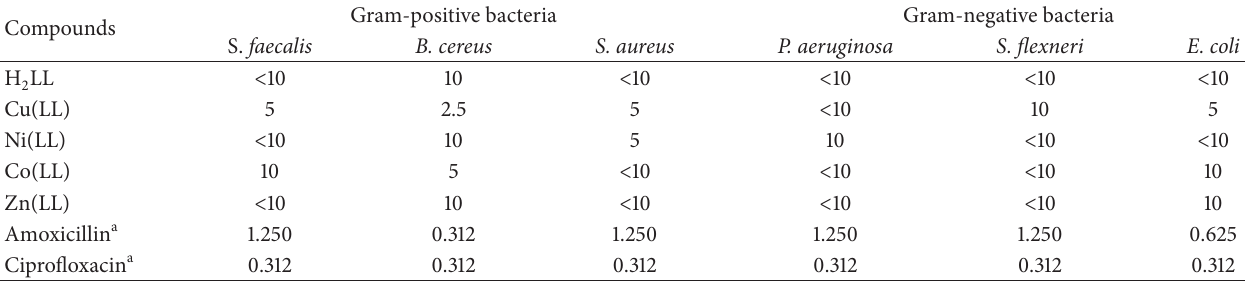
LL ] and its metal complexes. 2